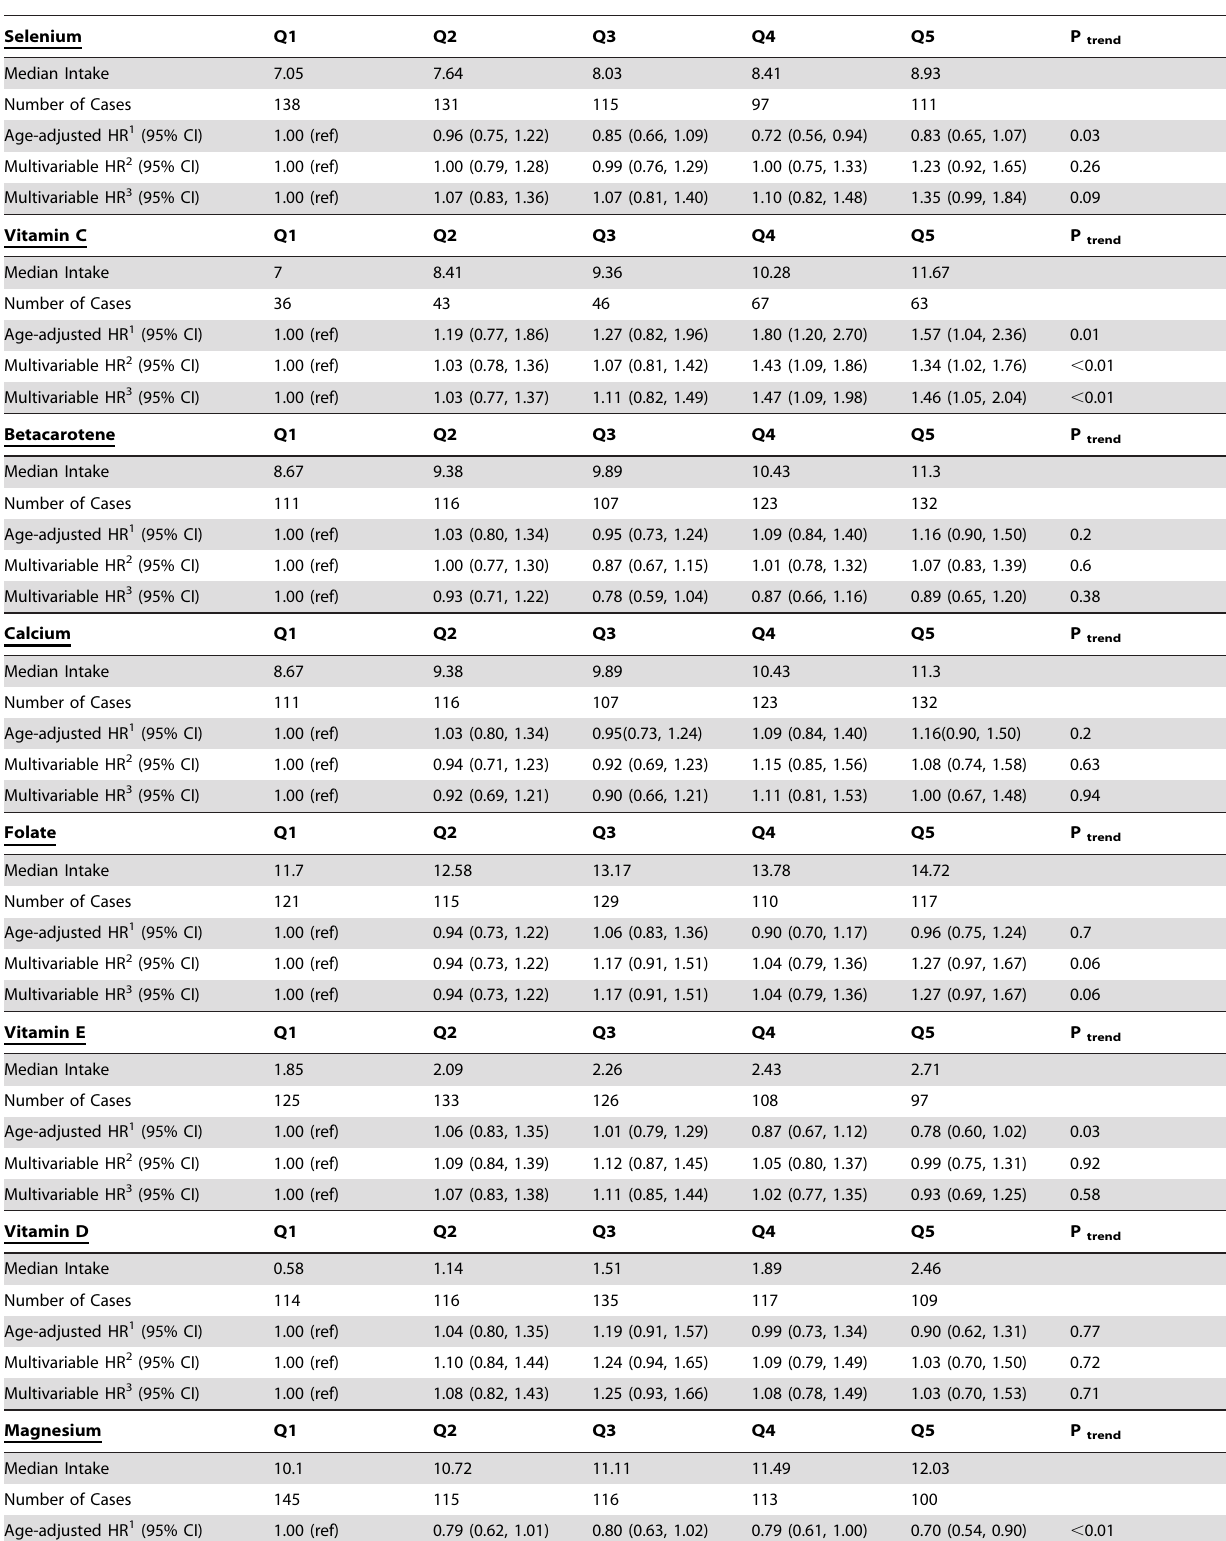
Table 3. Hazard Ratios (HRs) and corresponding 95% confidence intervals (CIs) for total thyroid cancer by quintile of micronutrient intake in men and women combined in The NIH-AARP Diet and Health